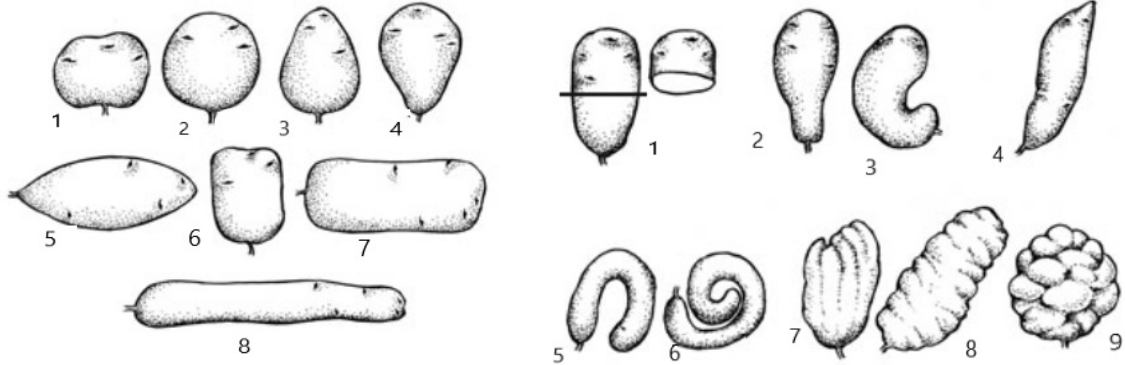
Figure 2. International Potato Center (CIP) descriptors for potato tuber shape. On the left , descriptors for general tuber shape: 1: Compressed; 2: Round; 3: Oval; 4: Obovate; 5: Elliptical; 6: Oblong; 7: Long oblong; 8: Elongate. On the right , descriptors for unusual tuber shape: 1: Flattened; 2: Clavate; 3 Reniform; 4: Fusiform; 5: Falcate; 6: Spiral; 7: Digitate; 8: Concertina; 9: Tuberosed [18].